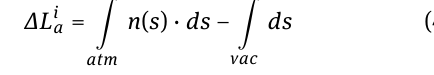
IWV and Precipitable Water (PW) can then be retrieved from the computed ZWD values. The ZTD is the same as ∆L i a ( ε ) mapped onto the zenith. They are computed by first considering ray bending due to refractivity of the at- mosphericmediummakingactualpathtakenbythesignal greater than the geometric path as shown in Ning